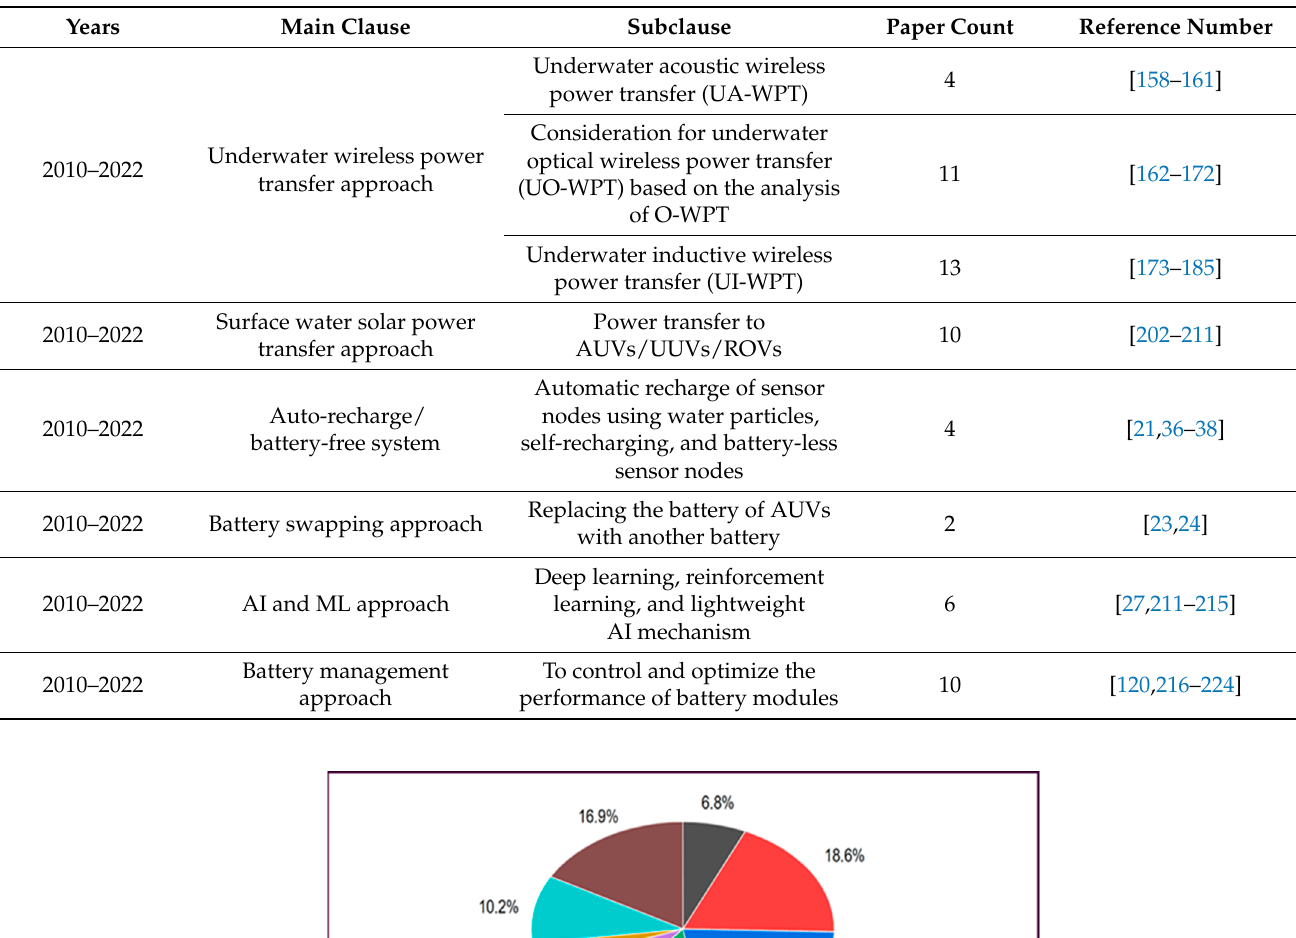
Table 4. Summary of various energy optimization techniques in UIoT.